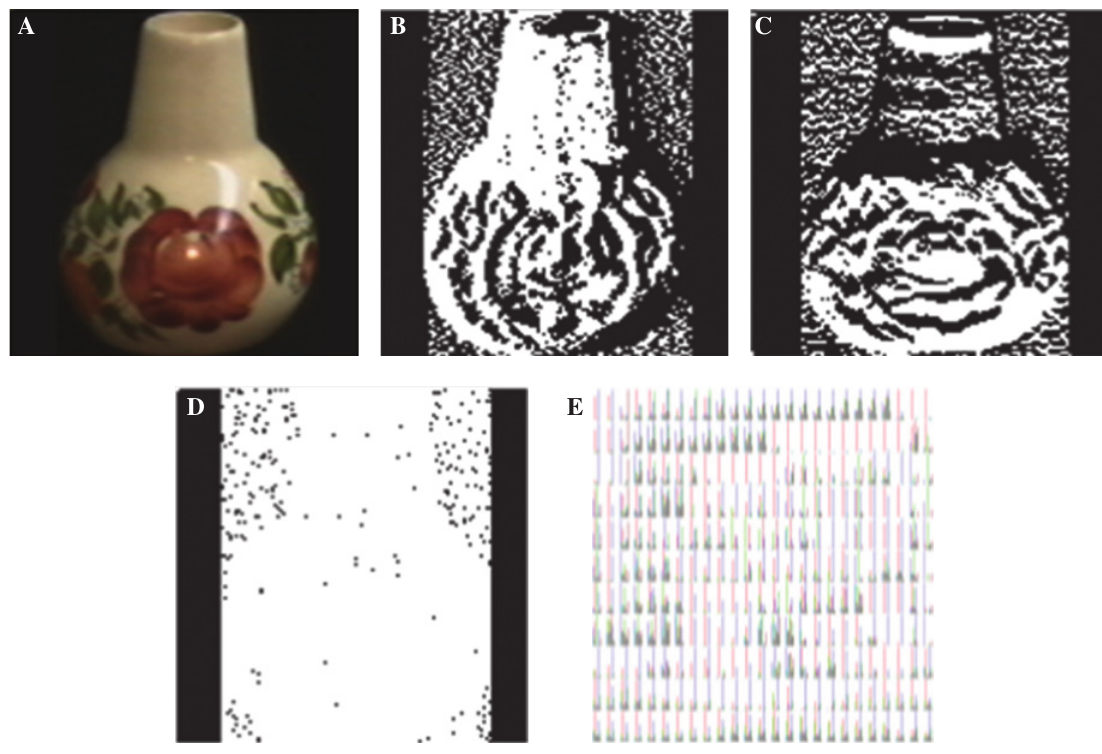
Figure 3: Process of Obtaining HOG Descriptors. (A) Initial image. (B) X derivate of the image. (C) Y derivate of the image. (D) Magnitude of gradient. (E) Histogram of oriented